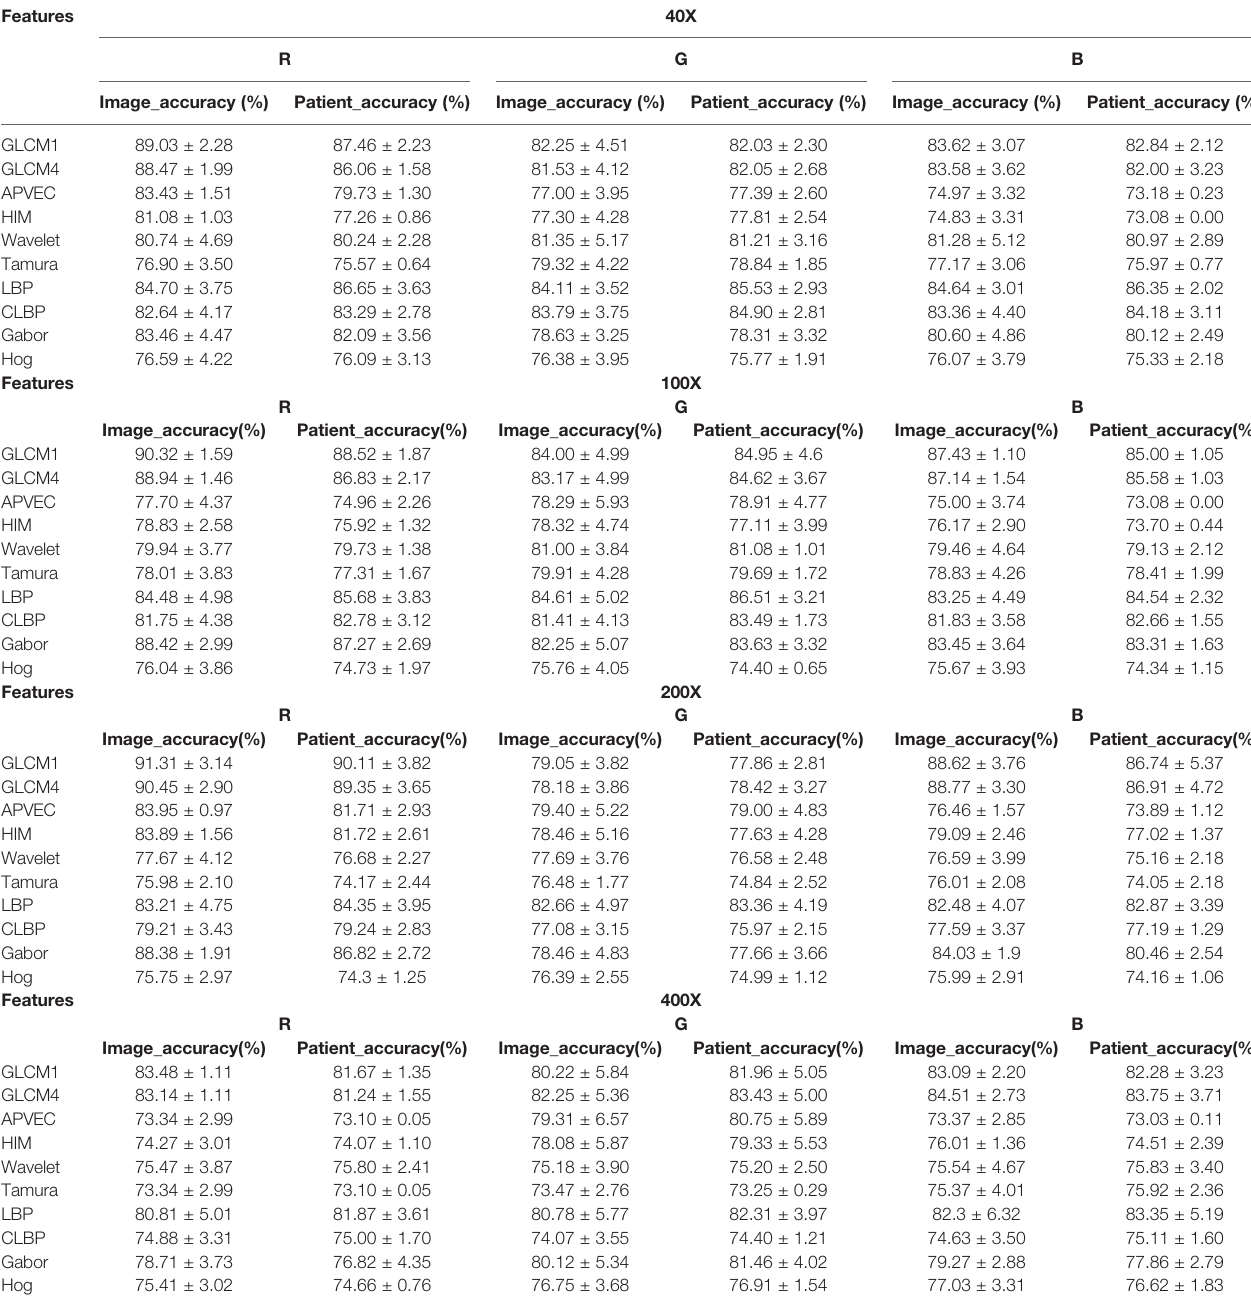
TABLE 6 | Classi fi cation performance of single-channel features under different magni fi cations. Features